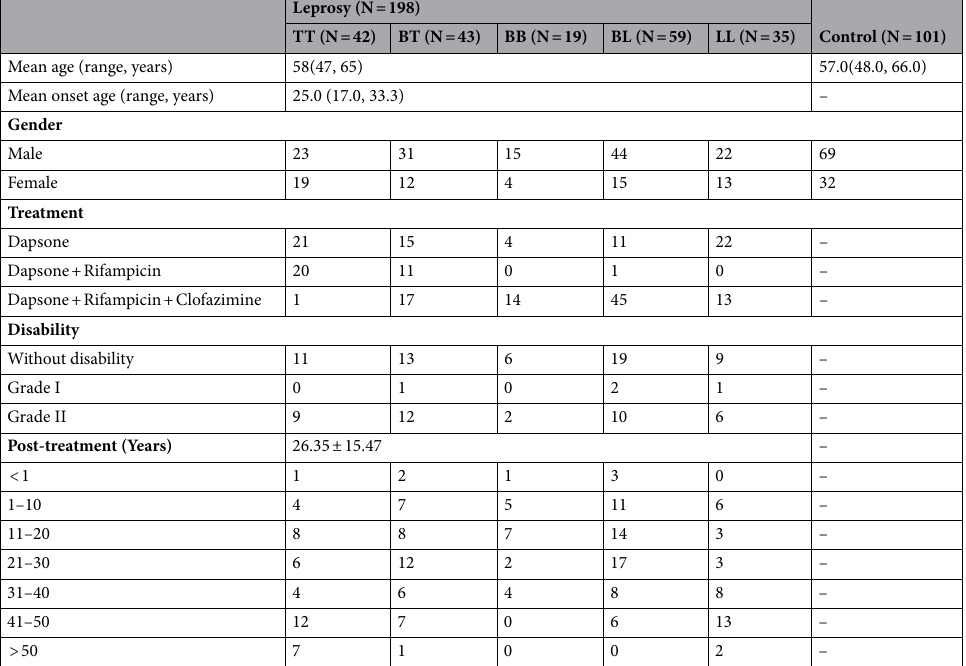
Table 1. Demographic and clinical characteristics of individuals enrolled in this